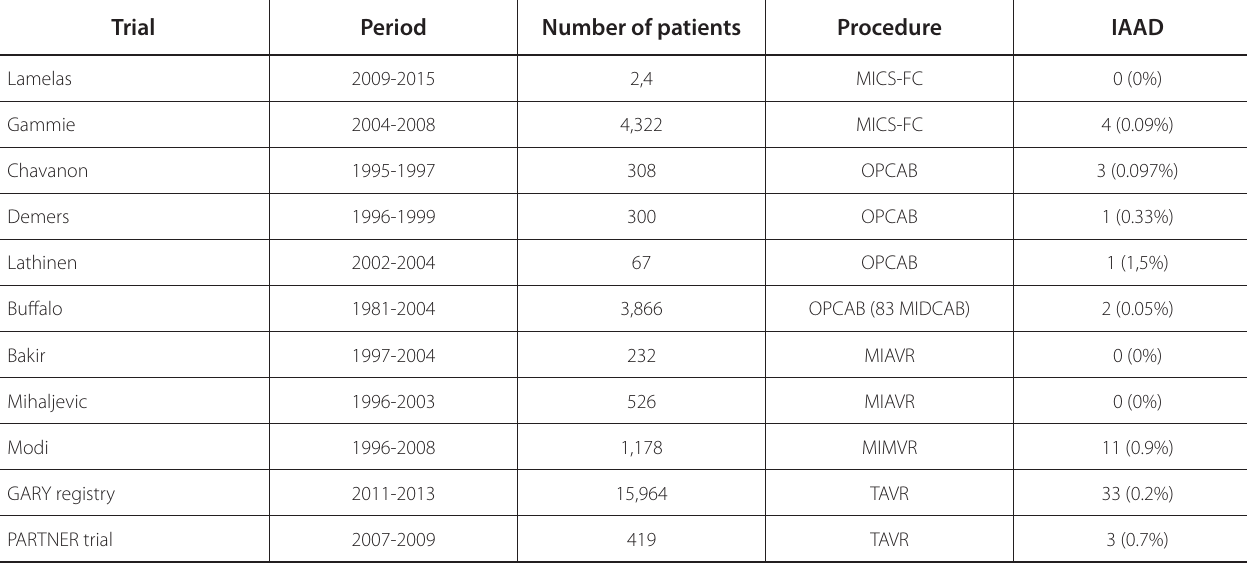
Table 4 . Trials of minimally invasive surgical interventions and transcatheter aortic valve replacement (TAVR) reporting the rate of iatrogenic acute aortic dissection